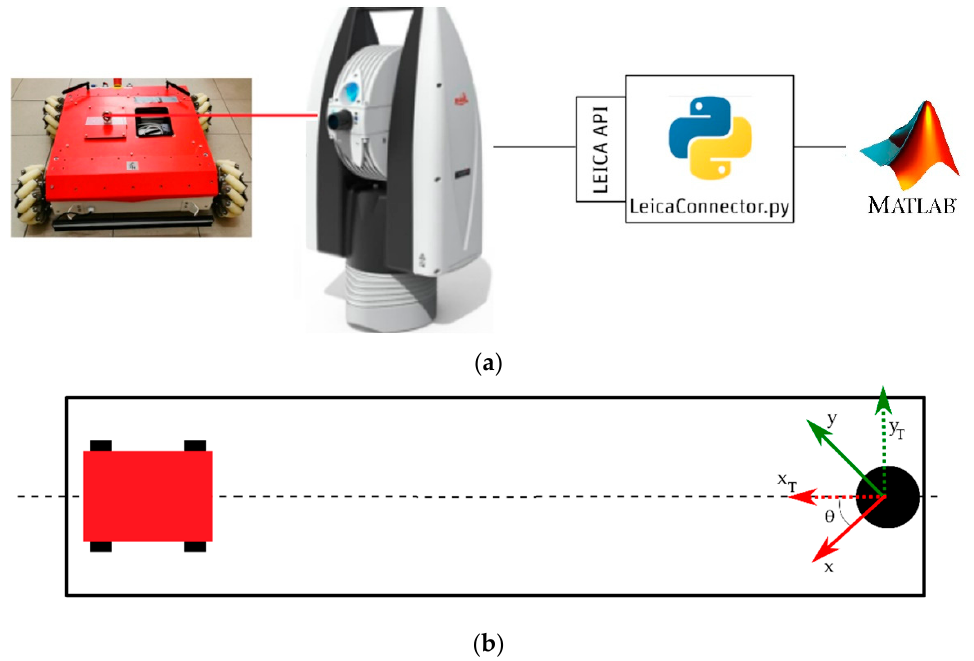
Figure 10. Test stand diagrams: ( a ) cooperation of a laser tracker and Matlab software in determin- ing the position of a 4-wheel mobile robot with mecanum wheels; ( b ) scheme of a measurement experiment.